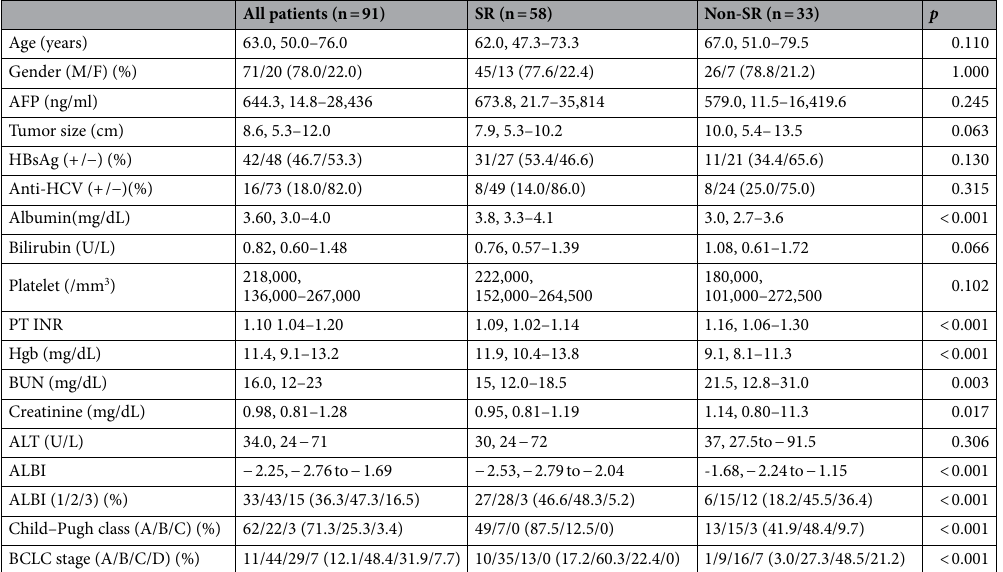
Table 1. Baselines demographics of enrolled patients. Continuous variables are expressed as the median with 25th and 75th percentiles. SR surgical resection, TACE trans-arterial chemoembolization, BMI body